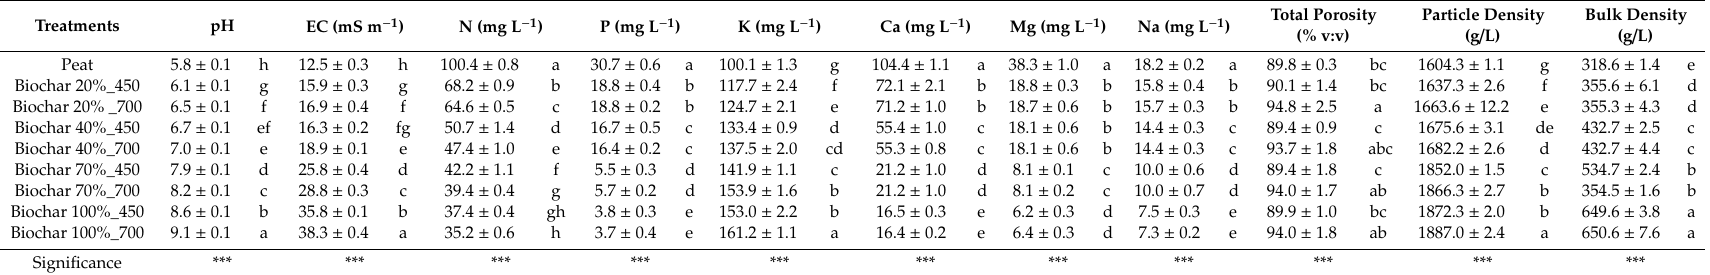
Table 2. ANOVA analysis and means comparisons for pH, EC, N, P, K, Ca, Mg, Na, total porosity, particle density and bulk density of di ff erent growing substrates.